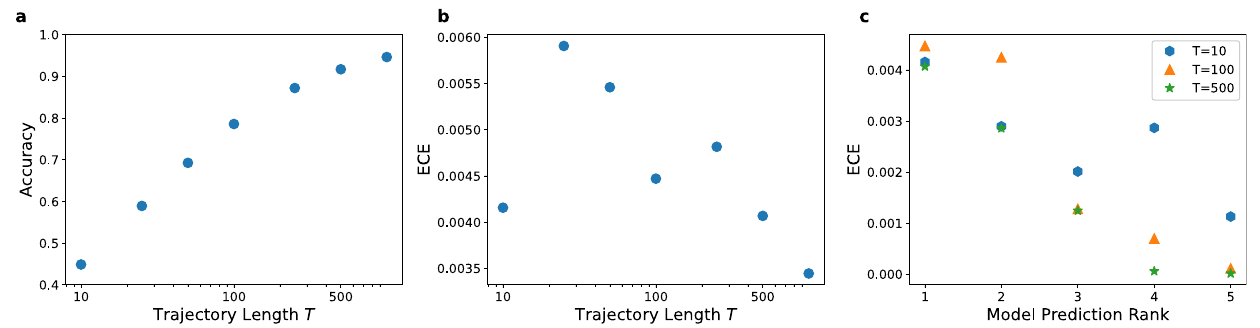
Fig. 7 | Performance evaluation for the classi fi cation of the diffusion model. a Total accuracy and b expected calibration error (ECE) 80,81 (see Supplementary Information fordetailedde fi nitions) achievedby Multi-SWAG , plotted for different trajectory lengths T by averaging over 10 5 trajectories each. The ECE describes the difference one may expect between the predicted con fi dence and the observed accuracy.Asbeforewe achieve alow calibration error between 0.3% and 0.6%. The classi fi cation accuracy improves the longer the trajectory, achieving results similar